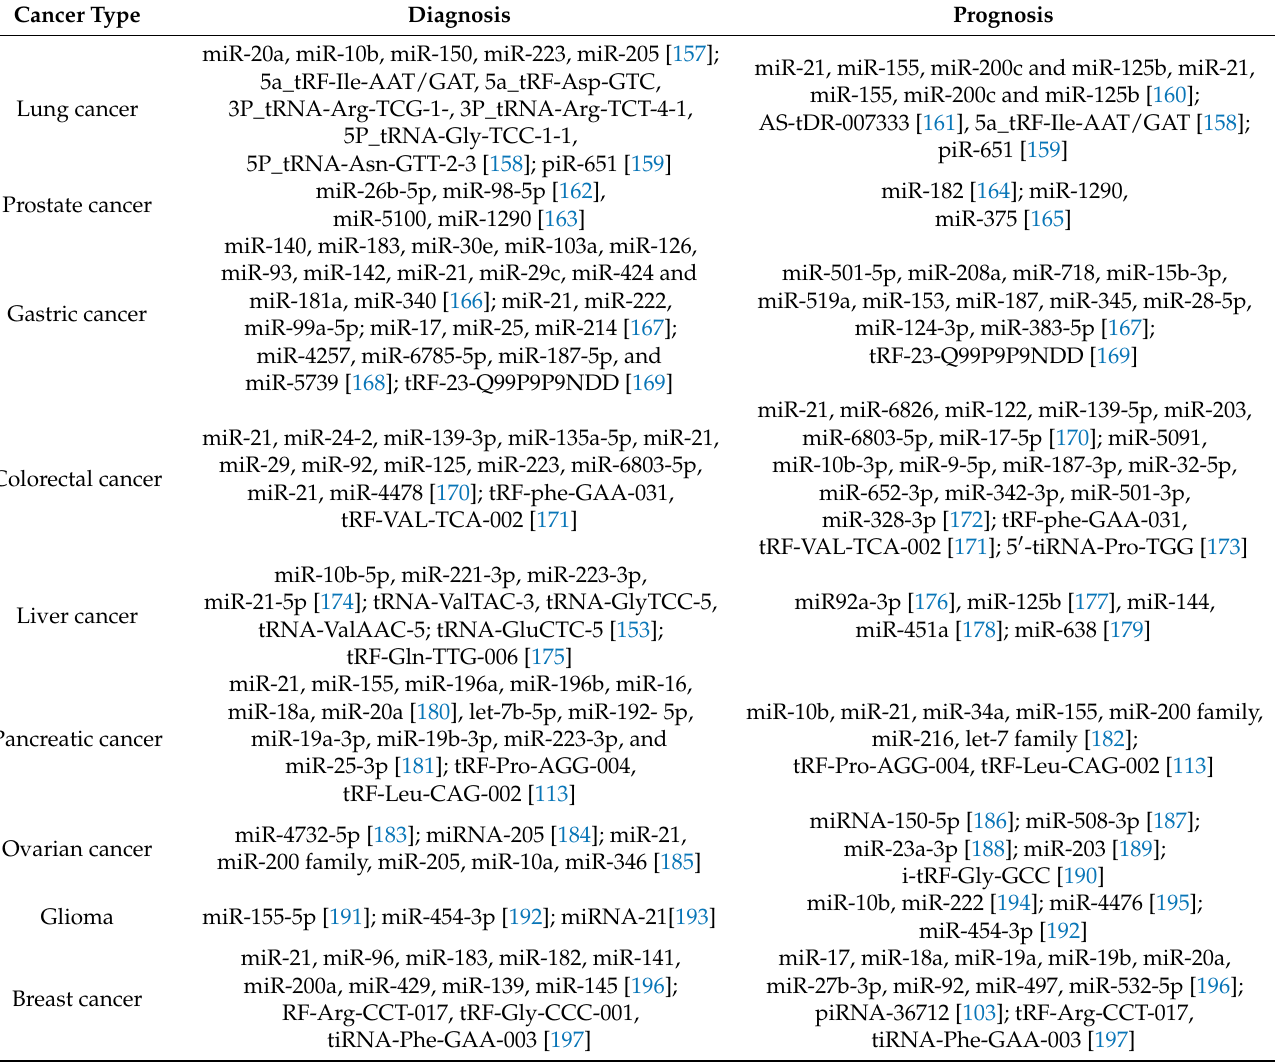
Table 2. Small non-coding RNAs as molecular biomarkers for cancer diagnosis or